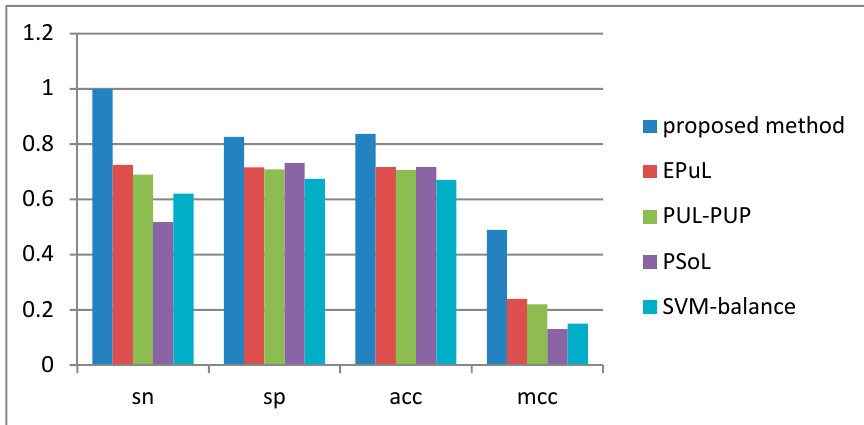
Figure 1. Comparison of performance between our model, EPuL, PUL-PUP, PSoL, and SVM balance on an independent test dataset.